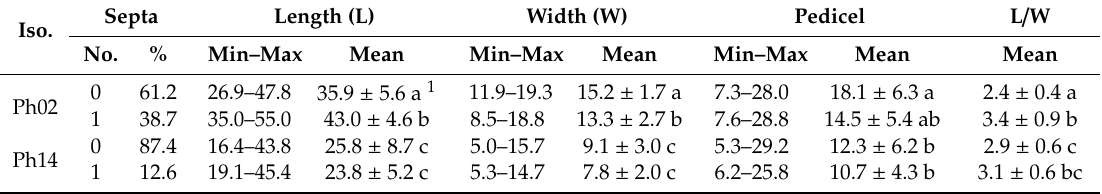
Table 3. Teliospores dimensions (in µ m) of two Puccinia hemerocallidis isolates collected in Portugal.